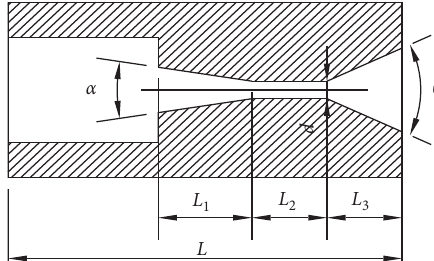
Figure 3: Schematic diagram of the nozzle